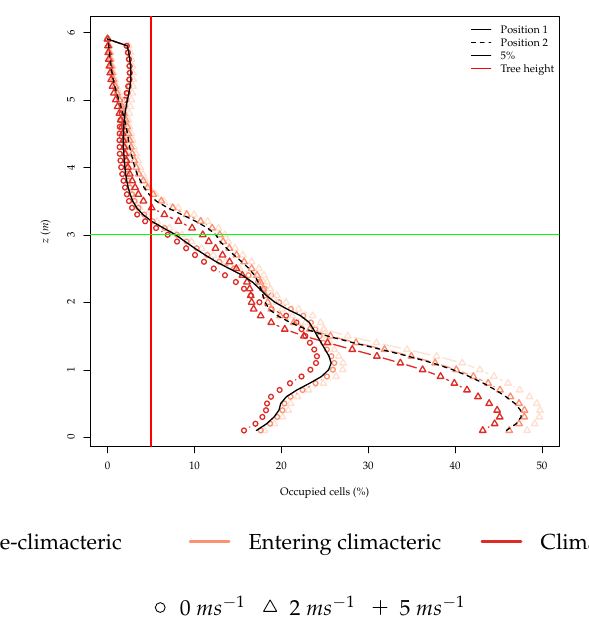
Figure 13. Percentage of occupied cells (cells with ethylene concentration higher than zero) in the environment across all time steps and simulations for the